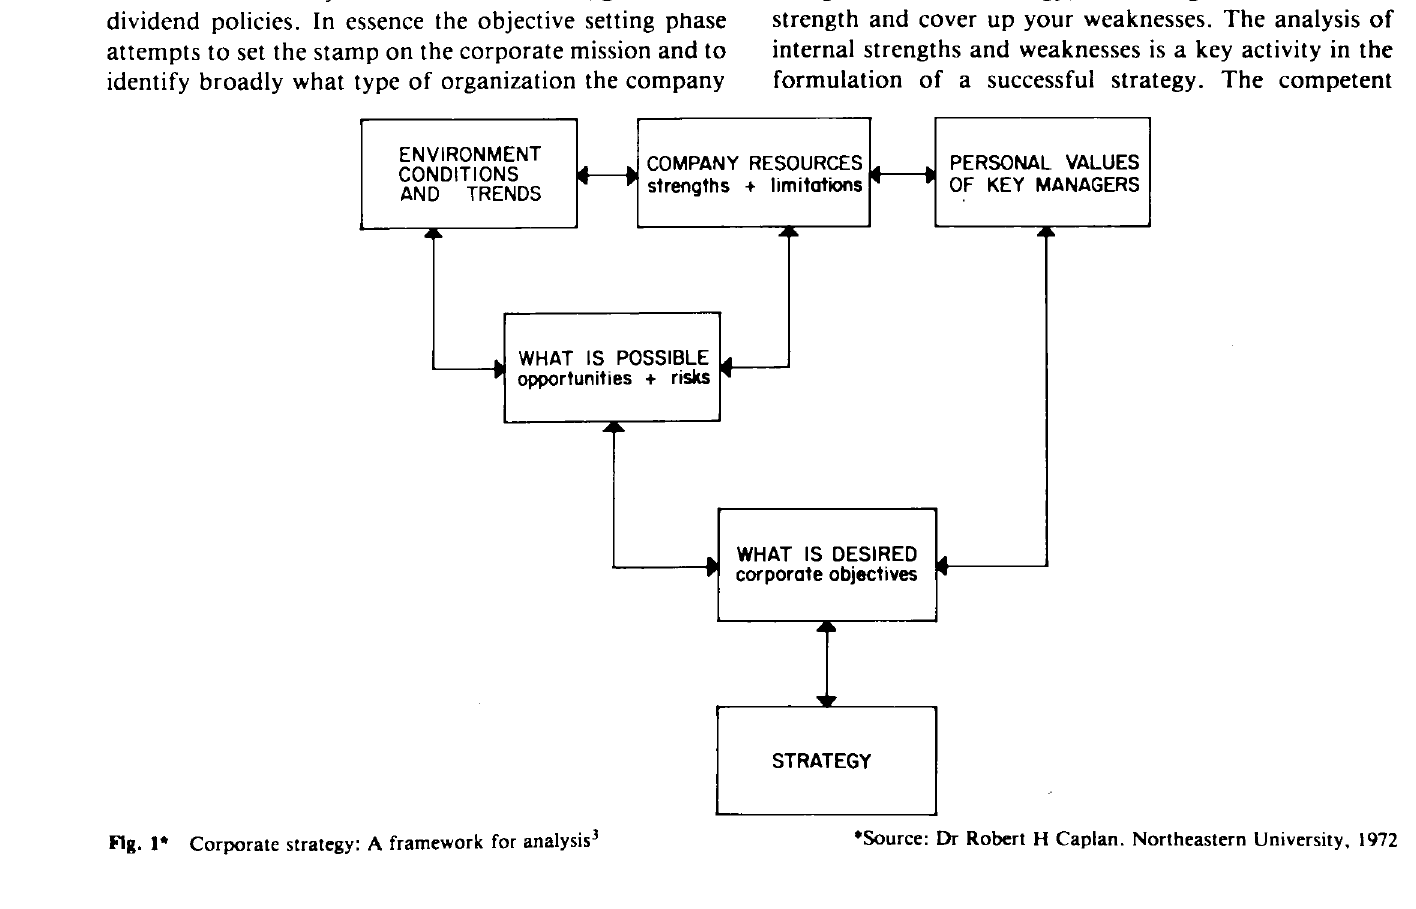
Fig. l* Corporate strategy: A framework for analysis